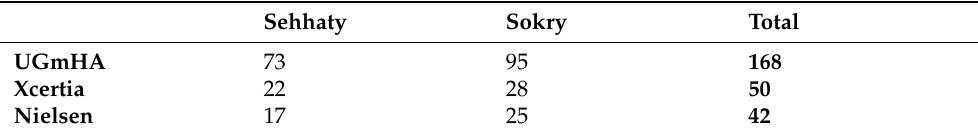
Table 11. Numbers of usability issues of both applications based on the three